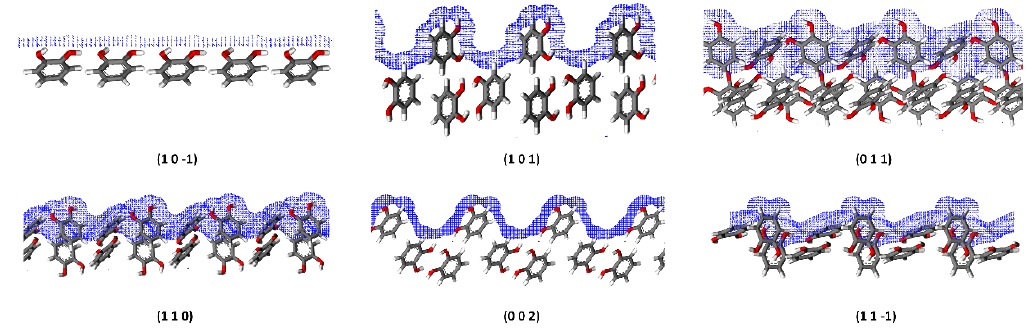
Table 4. The roughness values (S) of the dominant crystal faces of the catechol crystal.